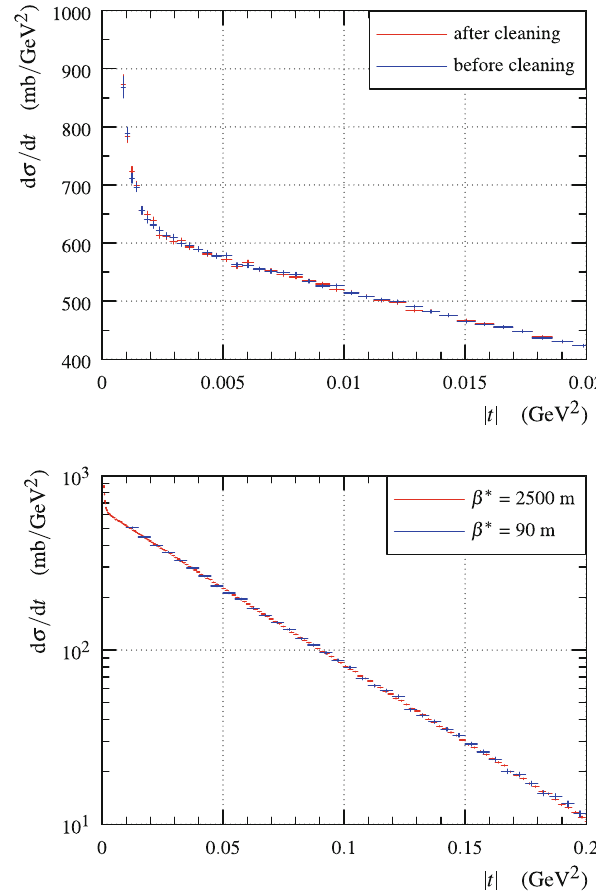
Fig. 12 Collection of cross-check plots (medium binning, only statis- tical uncertainties are plotted). Top left: comparison of results from the two diagonals, data from all LHC fills. Top right: comparison of results from time periods after and before beam cleanings, data from all LHC fills and both diagonals. Bottom left: comparison of results from “2RP”